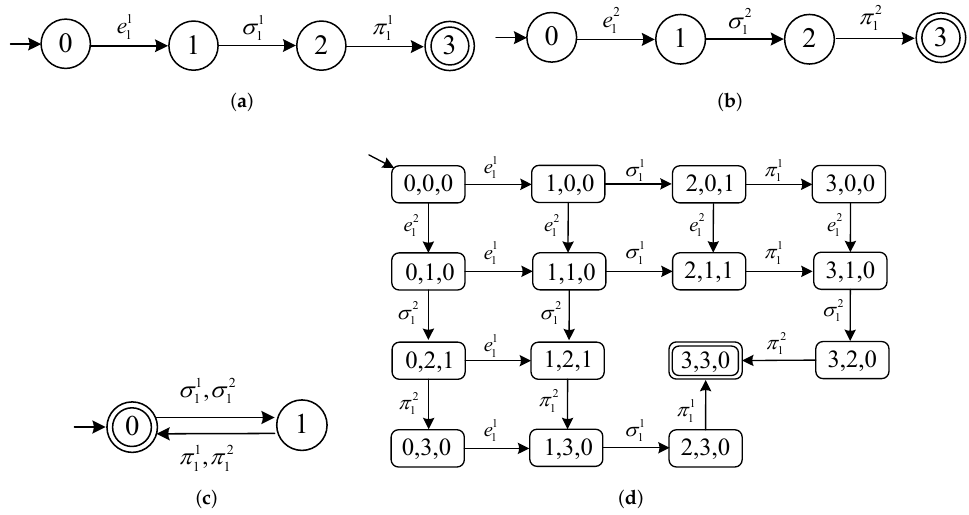
Figure 3. Automata P 1 , P 2 , R 1 , and G ; ( a ) Automaton P 1 for Robot 1; ( b ) Automaton P 2 for Robot 2; ( c ) Automaton R 1 for Resource 1; ( d ) System model G